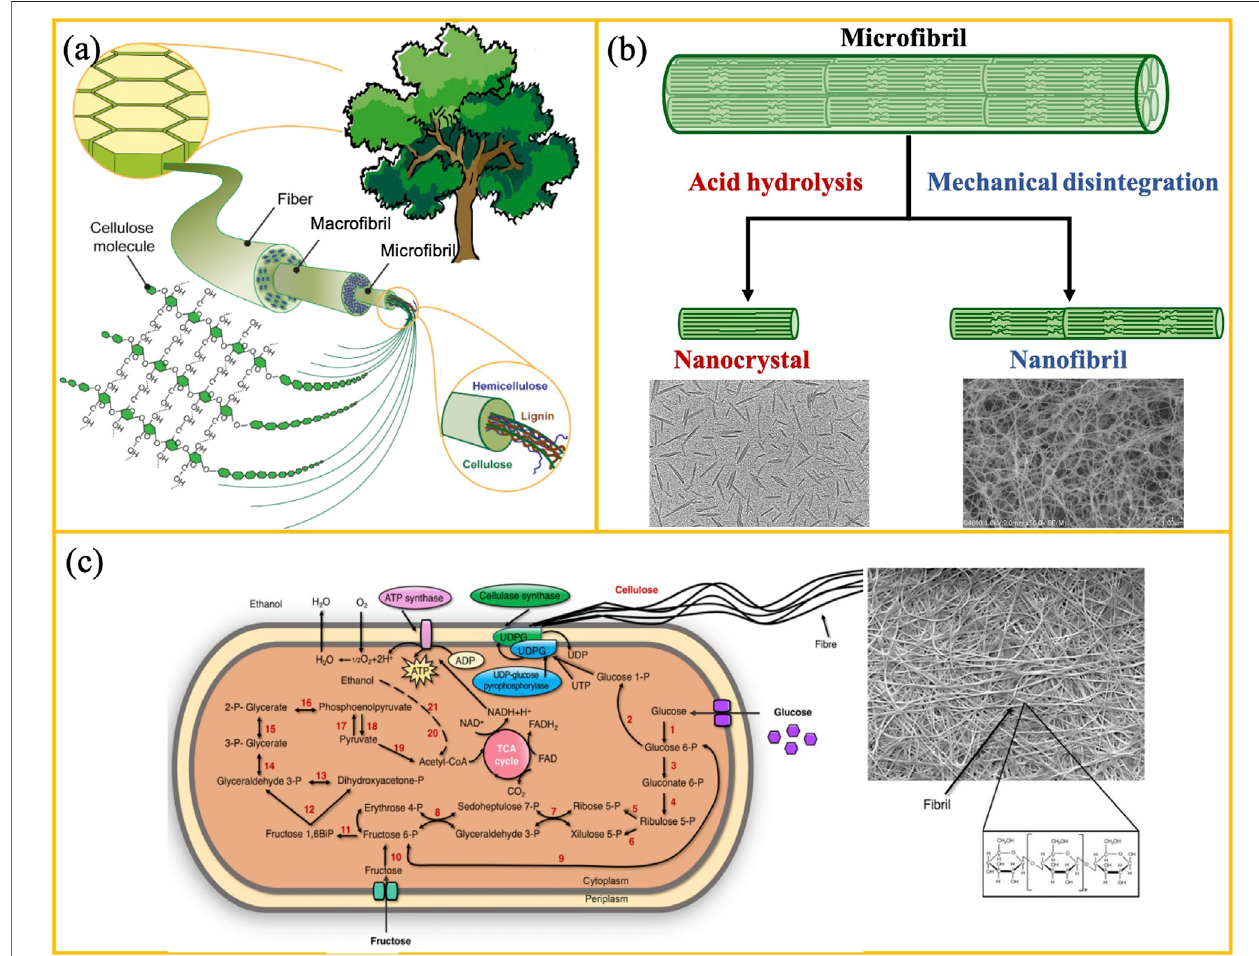
FIGURE 8 | (A) Schematic illustration of the hierarchical microstructure of cellulose in plant-based biomass. Adapted from Ghasemlou et al. (2021). (B) Schematic illustration of the synthesis of cellulose nanocrystals (CNCs) and cellulose nano fi brils (CNFs) from cellulose micro fi brils vial acid hydrolysis and mechanical disintegration, respectively. (C) Schematic illustration of biosynthesis of bacterial nanocellulose (BNC) and SEM micrograph adapted from Ifuku et al. (2007).